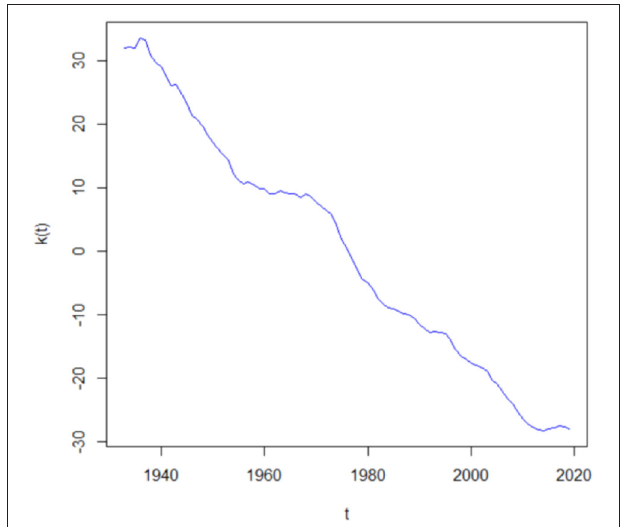
FIGURE 1 | Estimated k ( t ) from t